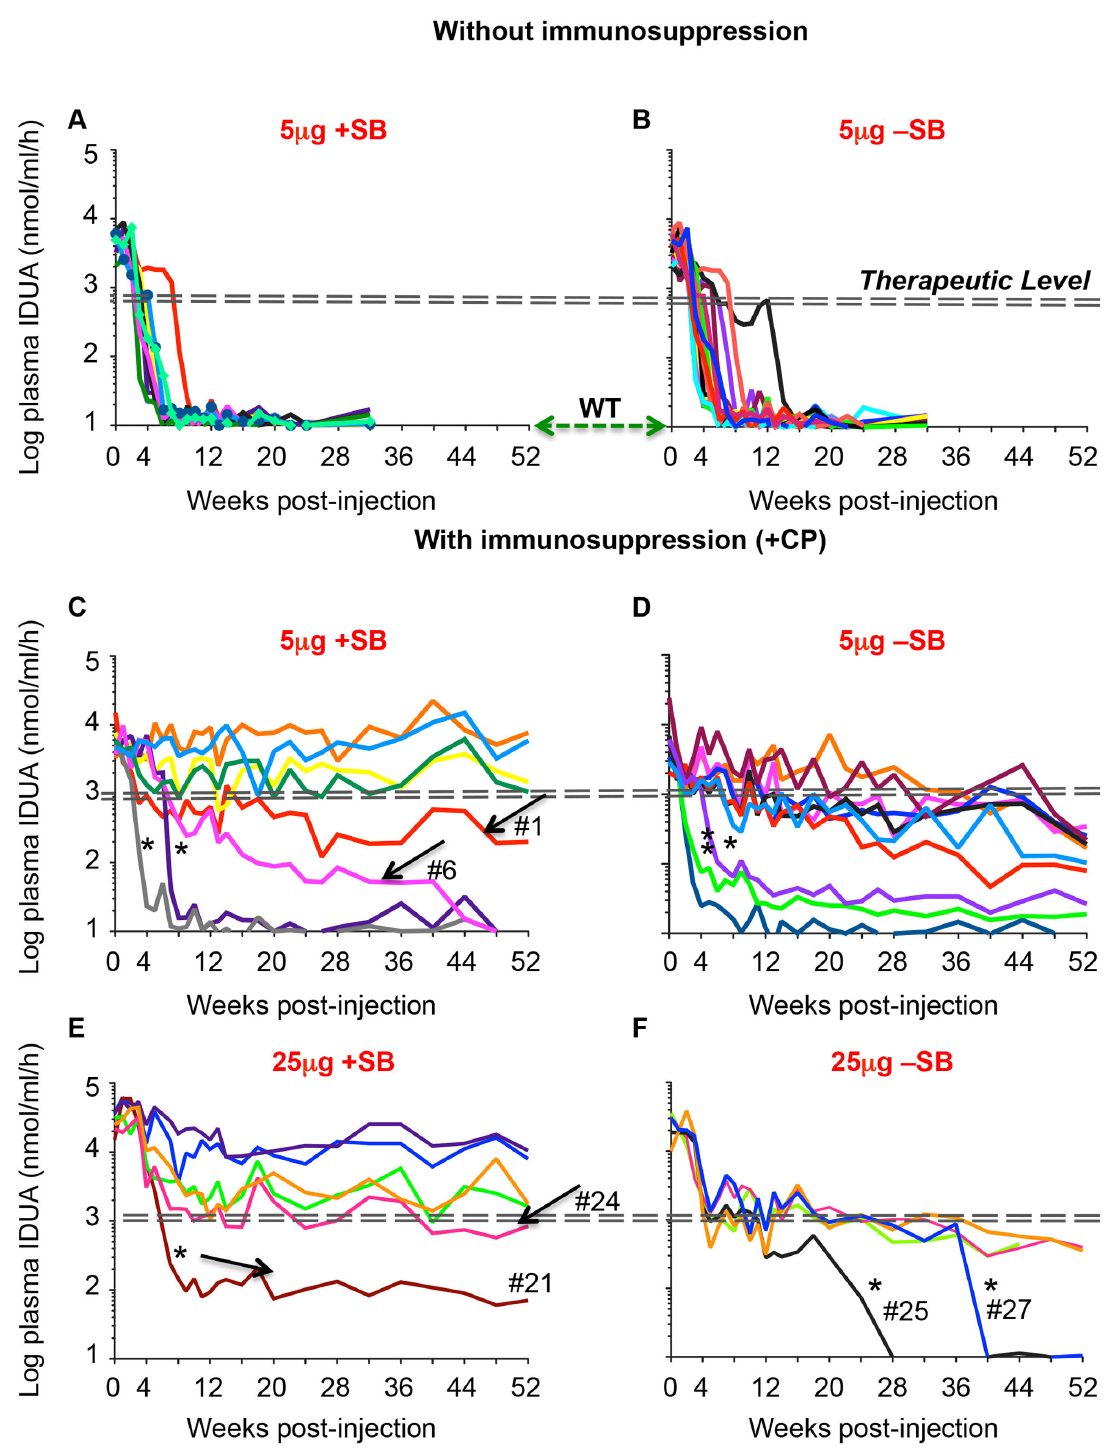
Figure 2. Expression of transgenic hIDUA in C57BL/6 mice. Mice aged 12 weeks were treated with 5μg or 25μg pKT2/LSP- IDUA ± pCMV-SB100X at 5:1 and 10:1 weight ratio, respectively. Plasma IDUA activity in untreated controls (WT) was 10±4 nmol/ml/hr. The dashed double-lines indicate the therapeutic level [8]. Arrows indicate expression profiles of +SB-treated mice with gradual or incomplete loss of IDUA activity. Asterisks indicate rapid decay in CP-immunosuppressed mice. Numbers indicate mouse IDs as listed in Table 1 . doi: 10.1371/journal.pone.0078161.g002 PLOS ONE |